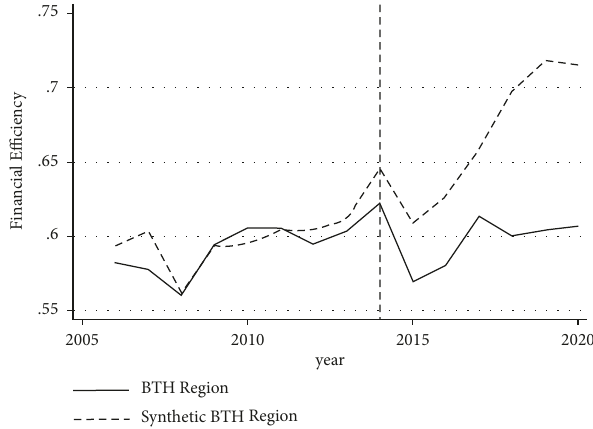
Figure 5: The BTH region and the synthetic BTH region’s financial efficiency change trend.